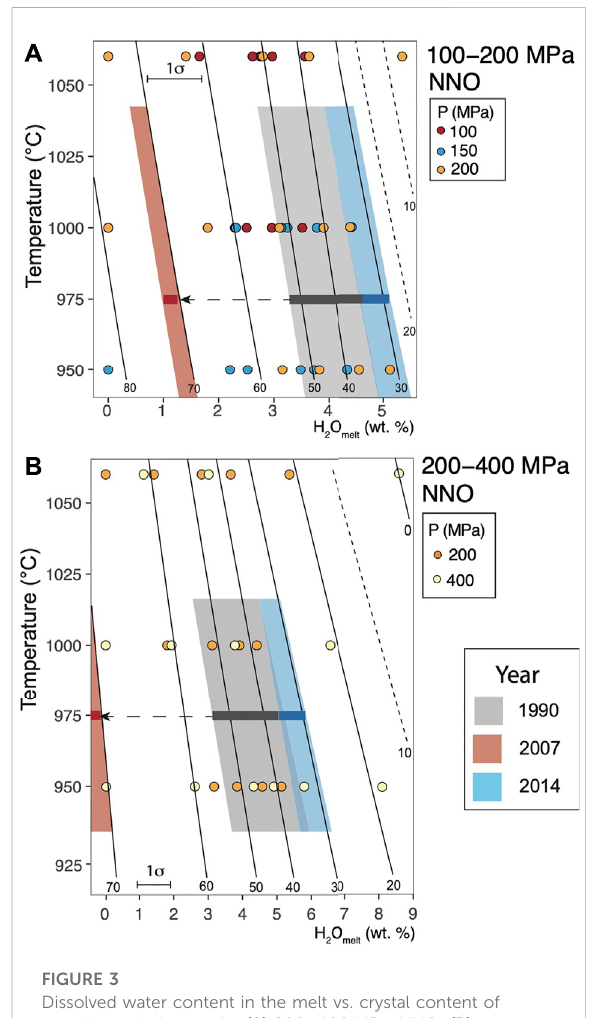
FIGURE 3 Dissolved water content in the melt vs. crystal content of experimental charges for (A) 200 – 400 MPa, NNO; (B) 100 – 200 MPa, NNO. Dashed lines denote extrapolated crystal contents of experimental charges. Gray, red, and blue semi- transparent boxes represent the fi eld bounded by the phenocryst content of natural samples, water content in the melt for thegiven temperature with SEE errors from Opx-melt geothermometer (975 ± 39 ° C) for the 1990 pumices (explosive), 2007 dome fragments(effusive),and2014pumices(explosive).Dashedarrows indicatepossiblechangesofwaterinthemeltduringascentforthe 2007 magma. The phenocryst contents of the erupted rocks are from Utami et al. (2021) and this study (Table 2). Average temperature estimates from each eruption are calculated from mineral-melt geothermobarometry listed in Table